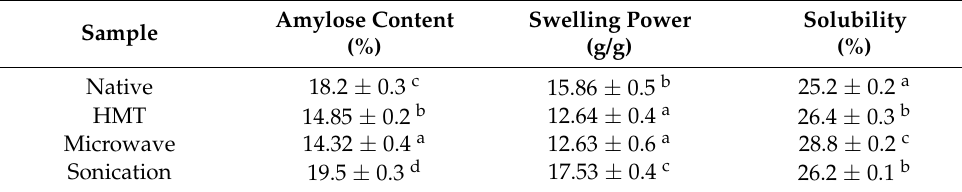
Table 1. Physicochemical properties of native and modified starches.